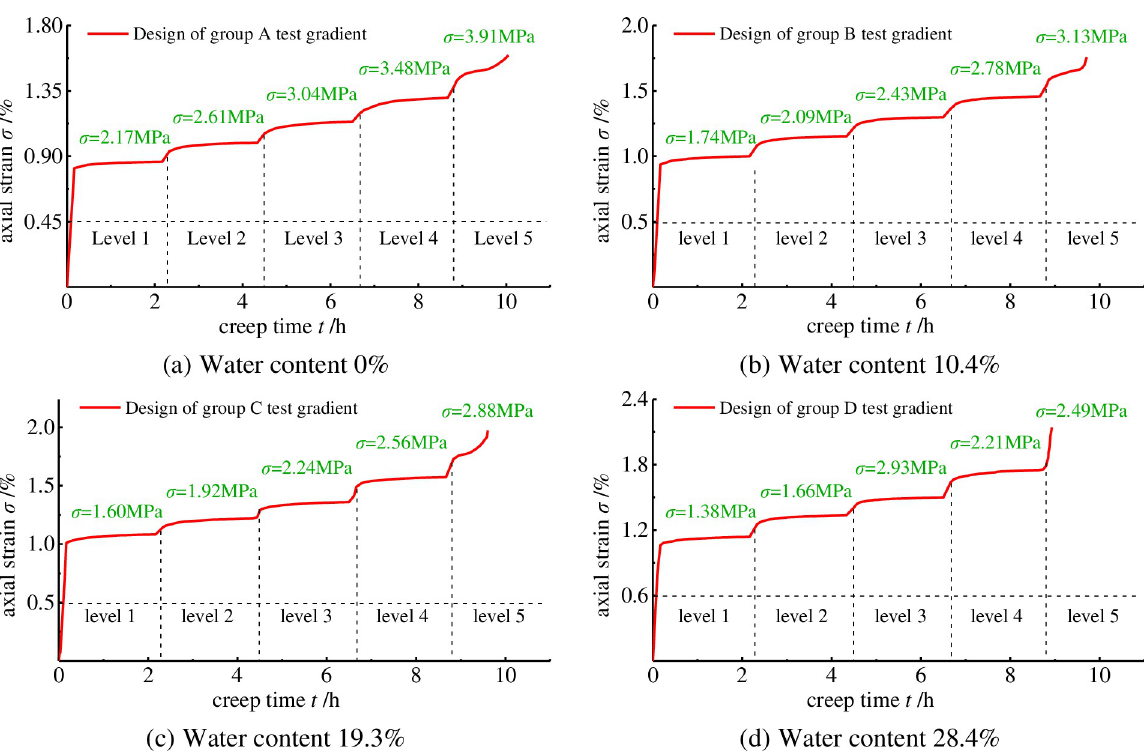
Fig 5. Axial strain curves at different water contents. (a) Water content 0%, (b) Water content 10.4%, (c) Water content 19.3%, (d) Water content 28.4%.